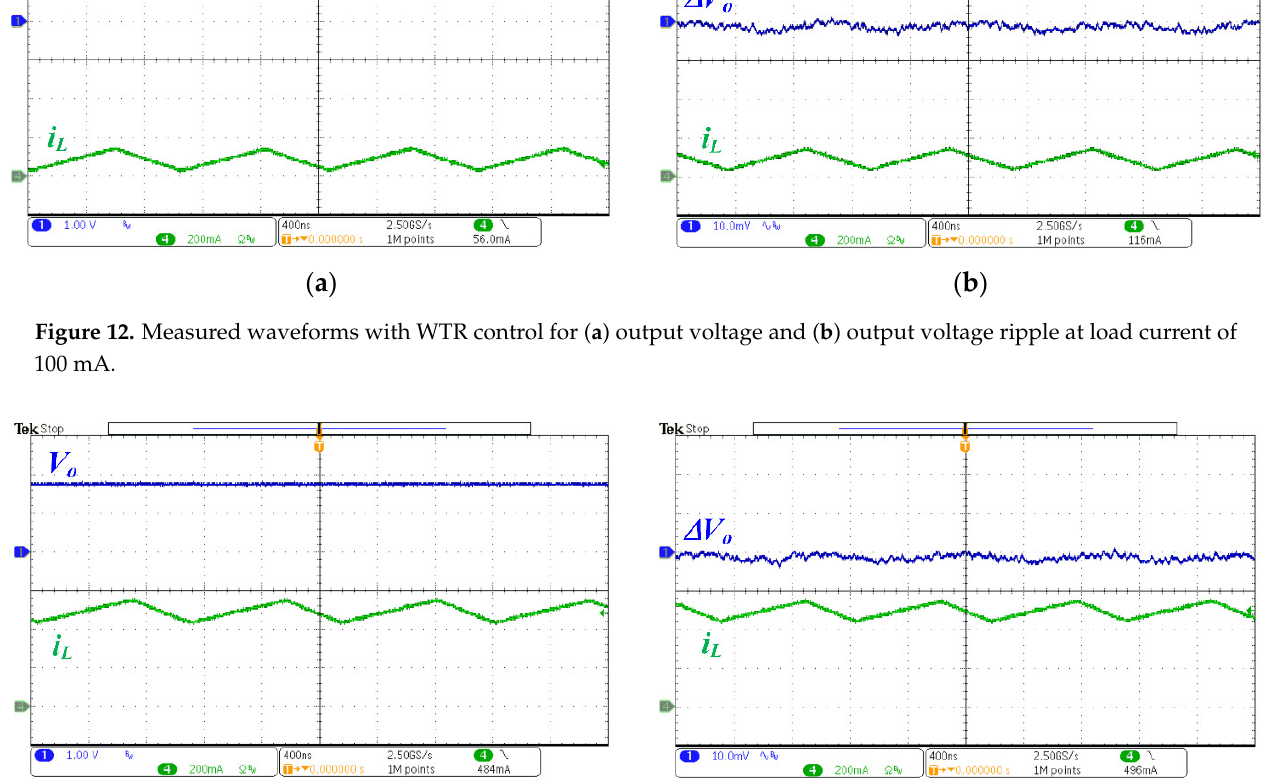
Figure 13. Measured waveforms with WTR control for ( a ) output voltage and ( b ) output voltage ripple at load current of 500 mA.